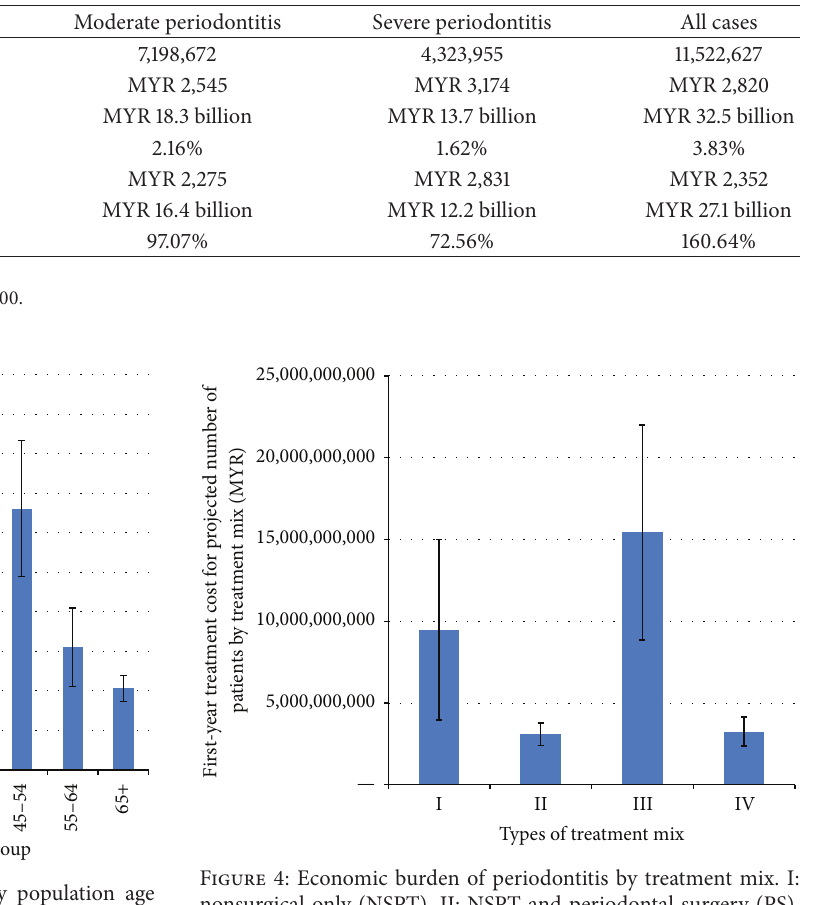
Table 3: Economic burden by periodontitis severity.